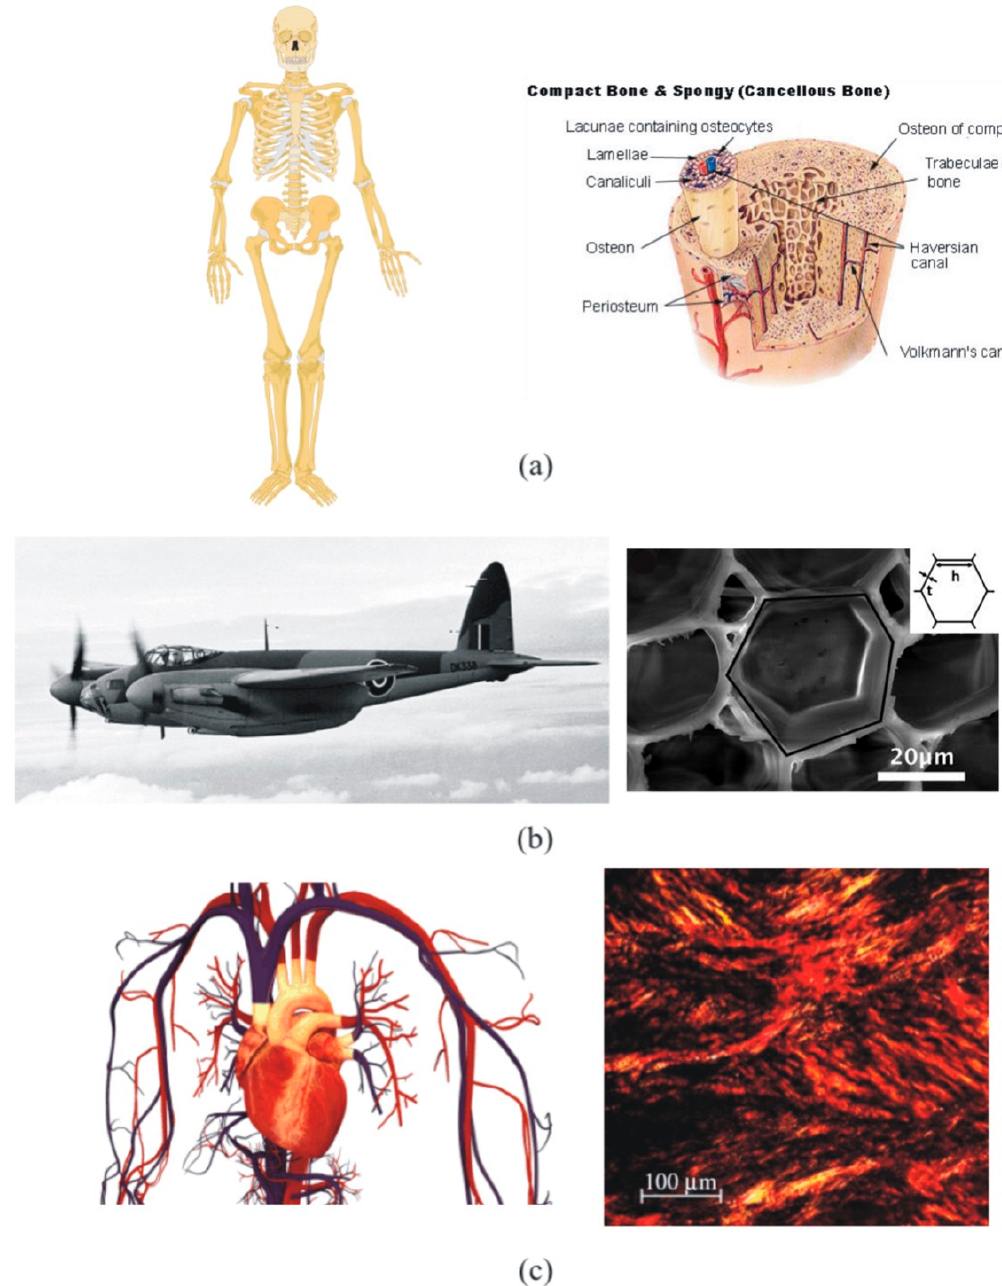
Figure 2. Examples taken from nature where different spatial scales can be distinguished. Left pictures are referred to the human (~m) scale (usually referred to as the ‘macroscopic’ or ‘coarse’ scale) while right ones correspond to a higher observation (~ µ m) scale (usually referred as the microscopic or finer scale): ( a ) human skeleton (left) and the typical microstructure of a flat bone (right). In this microstructure, one can visualize the engineering concept of a lightweight sandwich structure. The panels here refer to the cortical (low porosity) bone whereas the central zone is filled with cancellous (high porosity) bone; ( b ) World War II combat aircraft de Havilland Mosquito (left) and the microstructure (right) of its constituent materials (wood); ( c ) human vascular system (left) and microstructure of these soft fibered tissues showing the orientation of collagen fibers (right). All pictures taken from www.wikipedia.org except ( b ) right, taken with permission from [14].